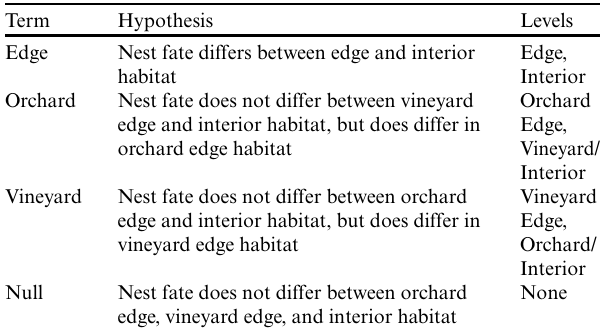
Table 4 . Hypotheses developed to test for an edge effect on songbird nest predation in sagebrush shrubsteppe habitat at two different types of agricultural edges: orchard and